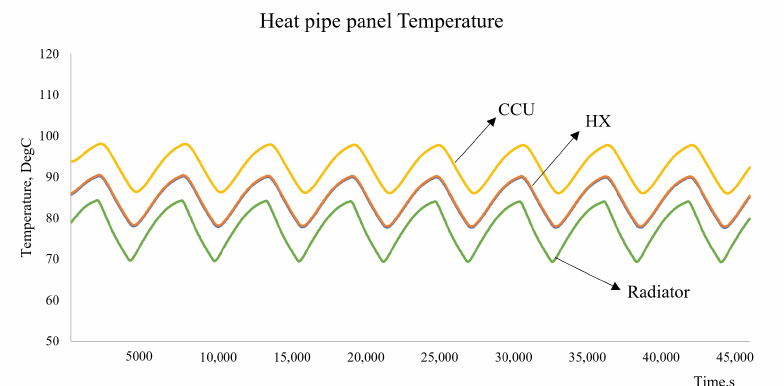
Figure 17. 6U Satellite body-mount radiator with heat